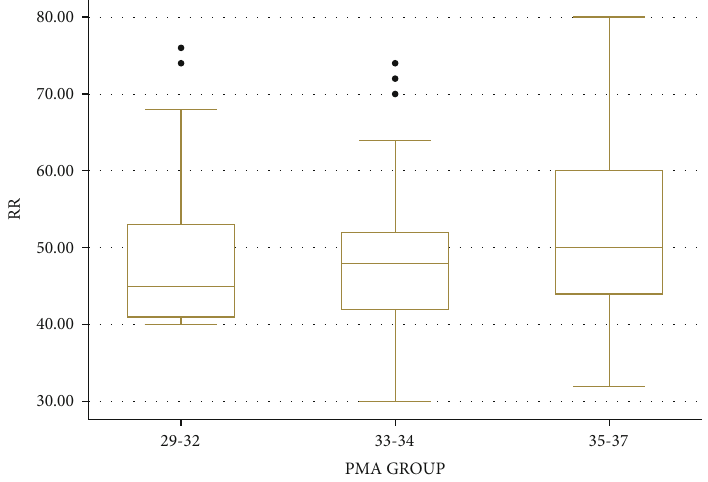
Figure 4: Boxplot showing distribution of RR based on PMA groups.